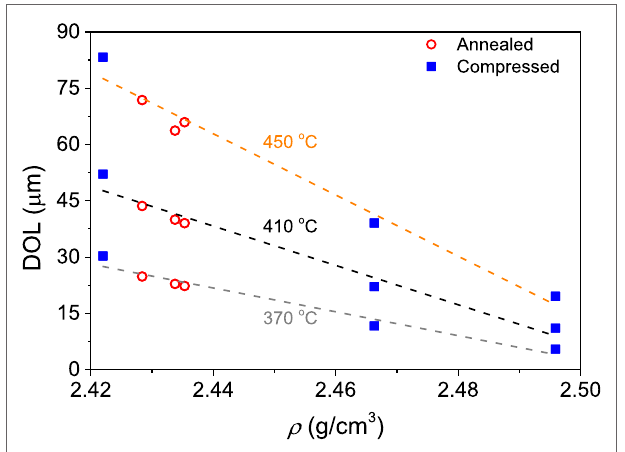
FigUre 7 | compressive stress (cs) as a function of density ( ρ ) for glasses ion exchanged at three different temperatures (370, 410, and 450° c) after annealing (open symbols) or compression (filled symbols) . Lines are guides for the eye.